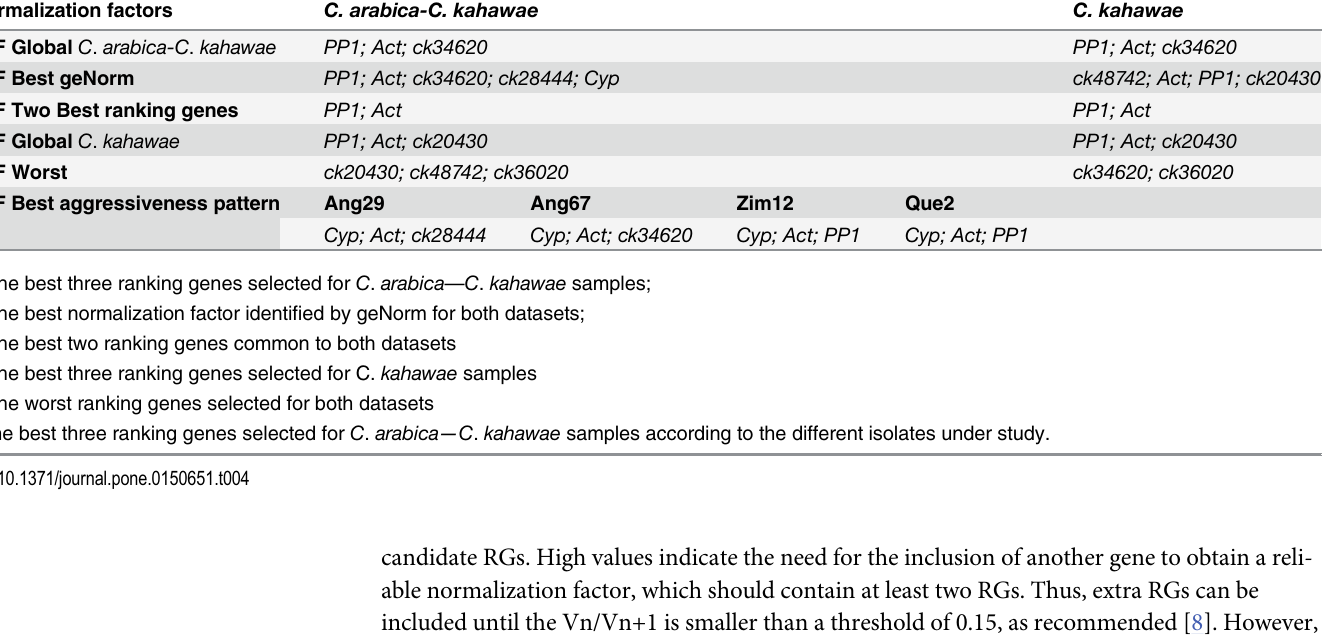
candidate RGs. High values indicate the need for the inclusion of another gene to obtain a reli- able normalization factor, which should contain at least two RGs. Thus, extra RGs can be included until the Vn/Vn+1 is smaller than a threshold of 0.15, as recommended [8]. However, this is not an absolute value and it can change according to the data [8]. As shown in Fig 2, the pairwise variation values, for both datasets, are higher than the recommended cut-off value. Based on this parameter, the use of five reference genes (V5/6 = 0.224248) for the C . arabica —